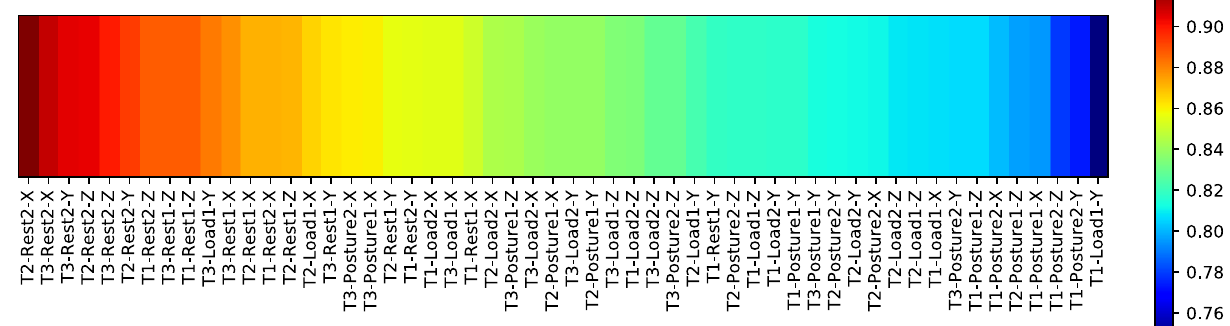
Figure 8. Results of sequential feature selection for the features that are fed to the second-stage classifier. Please note that these results are obtained through a 5-fold cross-validation process, when 75% of dataset is used for training. It should be highlighted that in this analysis, the probabilistic features due to their superior performance over binary features are employed, and the label of each feature is formed as [TrialNumber-